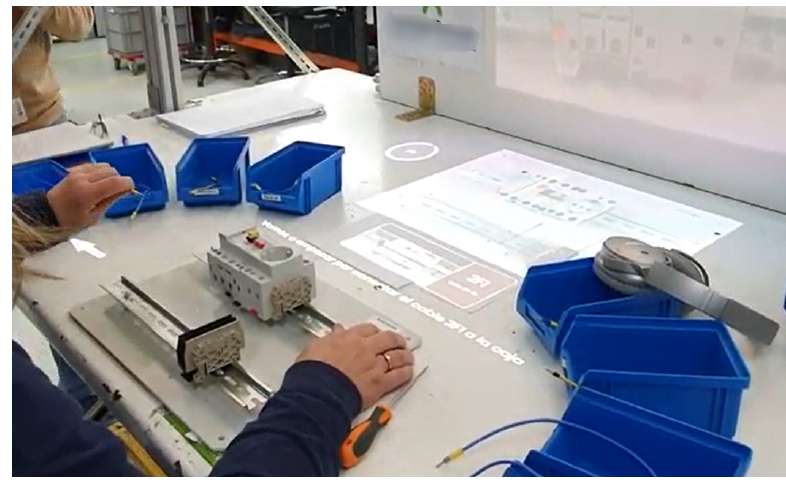
Figure 5. Operator performing a cabling